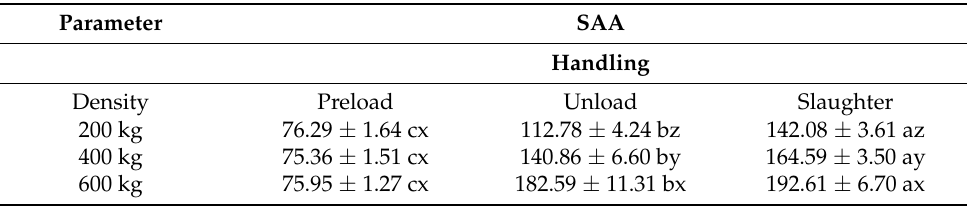
Table 9. Serum amyloid A (SAA) as affected by the interaction between handling and stocking density in road transported cattle.